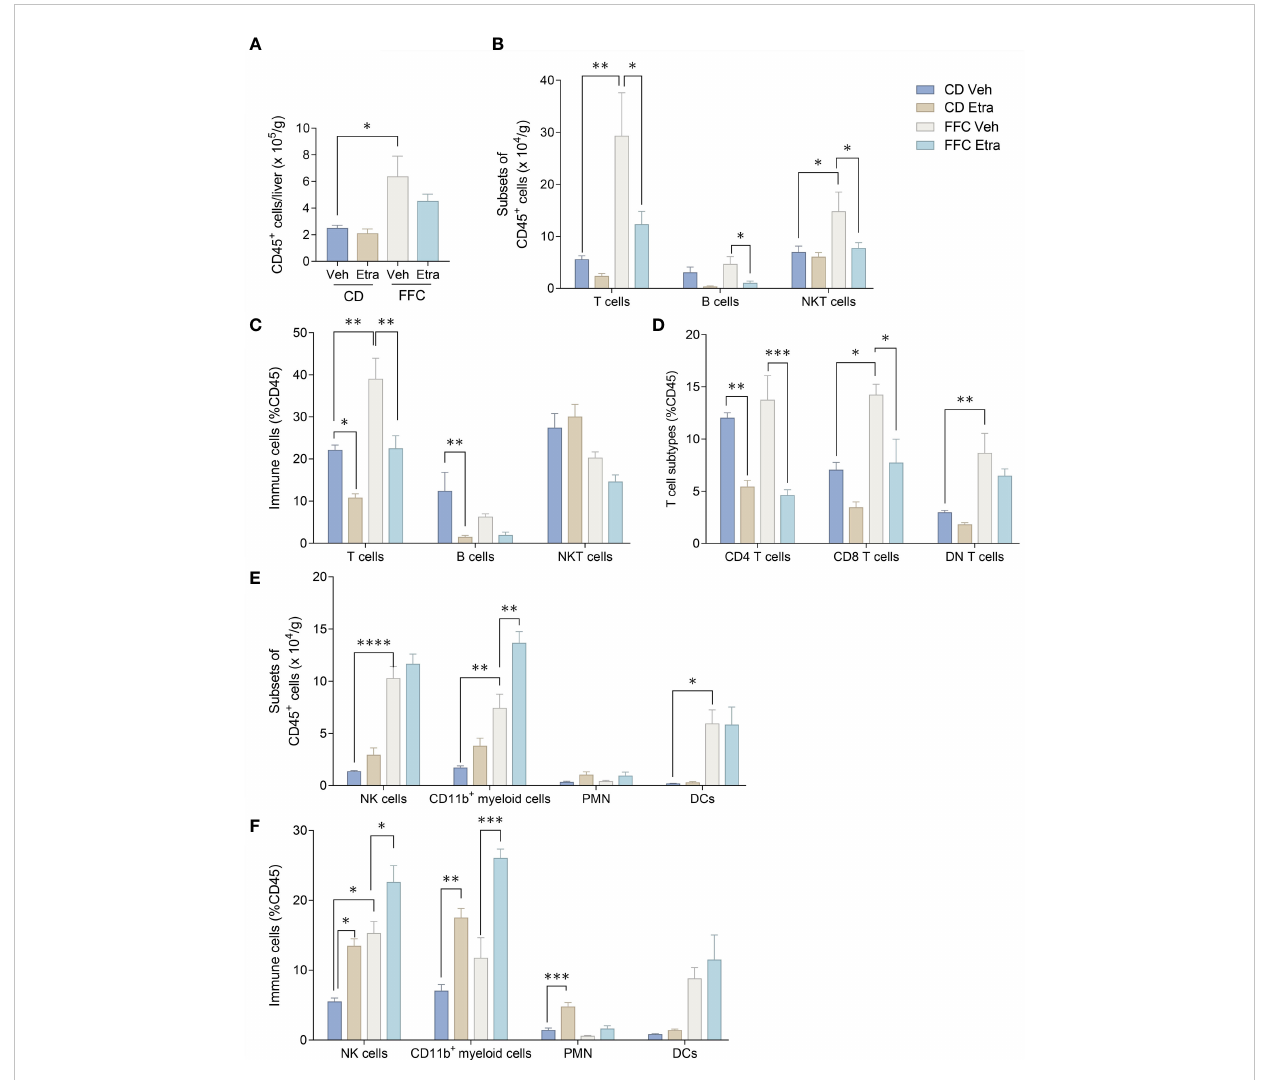
FIGURE 4 Etrasimod treatment alters intrahepatic leukocyte populations. (A) Number of CD45 + cells per gram acquired for FACS analysis in CD and FFC cohorts. (B) Subsets of CD45 + cells, (C) immune cell pro fi ling expressed in %CD45 cells that are T cells, B cells and NKT cells by FACS analysis in livers from CD and FFC cohorts that received vehicle or Etrasimod treatment. (D) T-cell subtypes expressed in %CD45 cells that are CD4 positive, CD8 positive or double negative in CD and FFC cohorts. (E) Subsets of CD45 + cells that are NK cells, CD11b + myeloid cells, PMNs and DCs. (F) Immune cells expressed in %CD45 that are NK cells, CD11b + myeloid cells, PMNs and DCs. CD (vehicle n=4, Etrasimod n=6) and FFC (vehicle n=5, Etrasimod n=5). *p<0.05, **p<0.01, ***p<0.001,